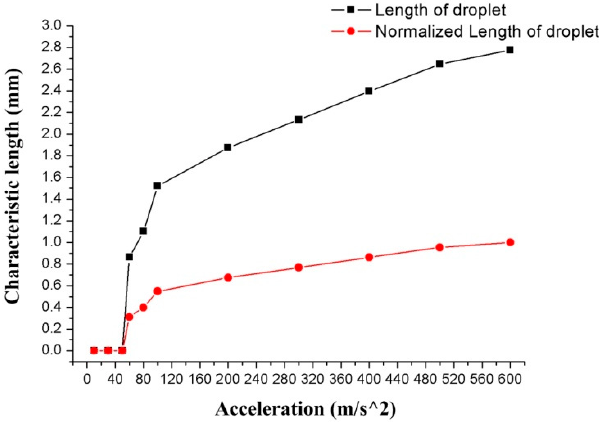
Figure 8. The results of characteristic-length (C-length) of droplet deformation at different accelerations.